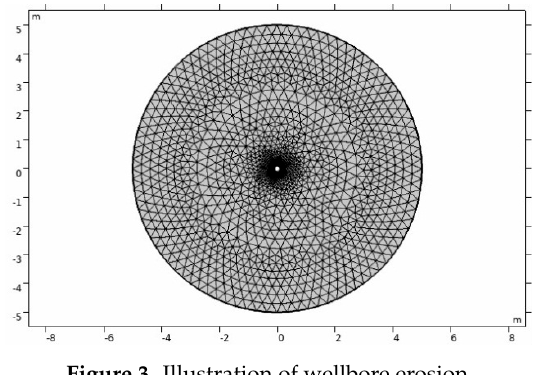
Figure 3. Illustration of wellbore erosion.